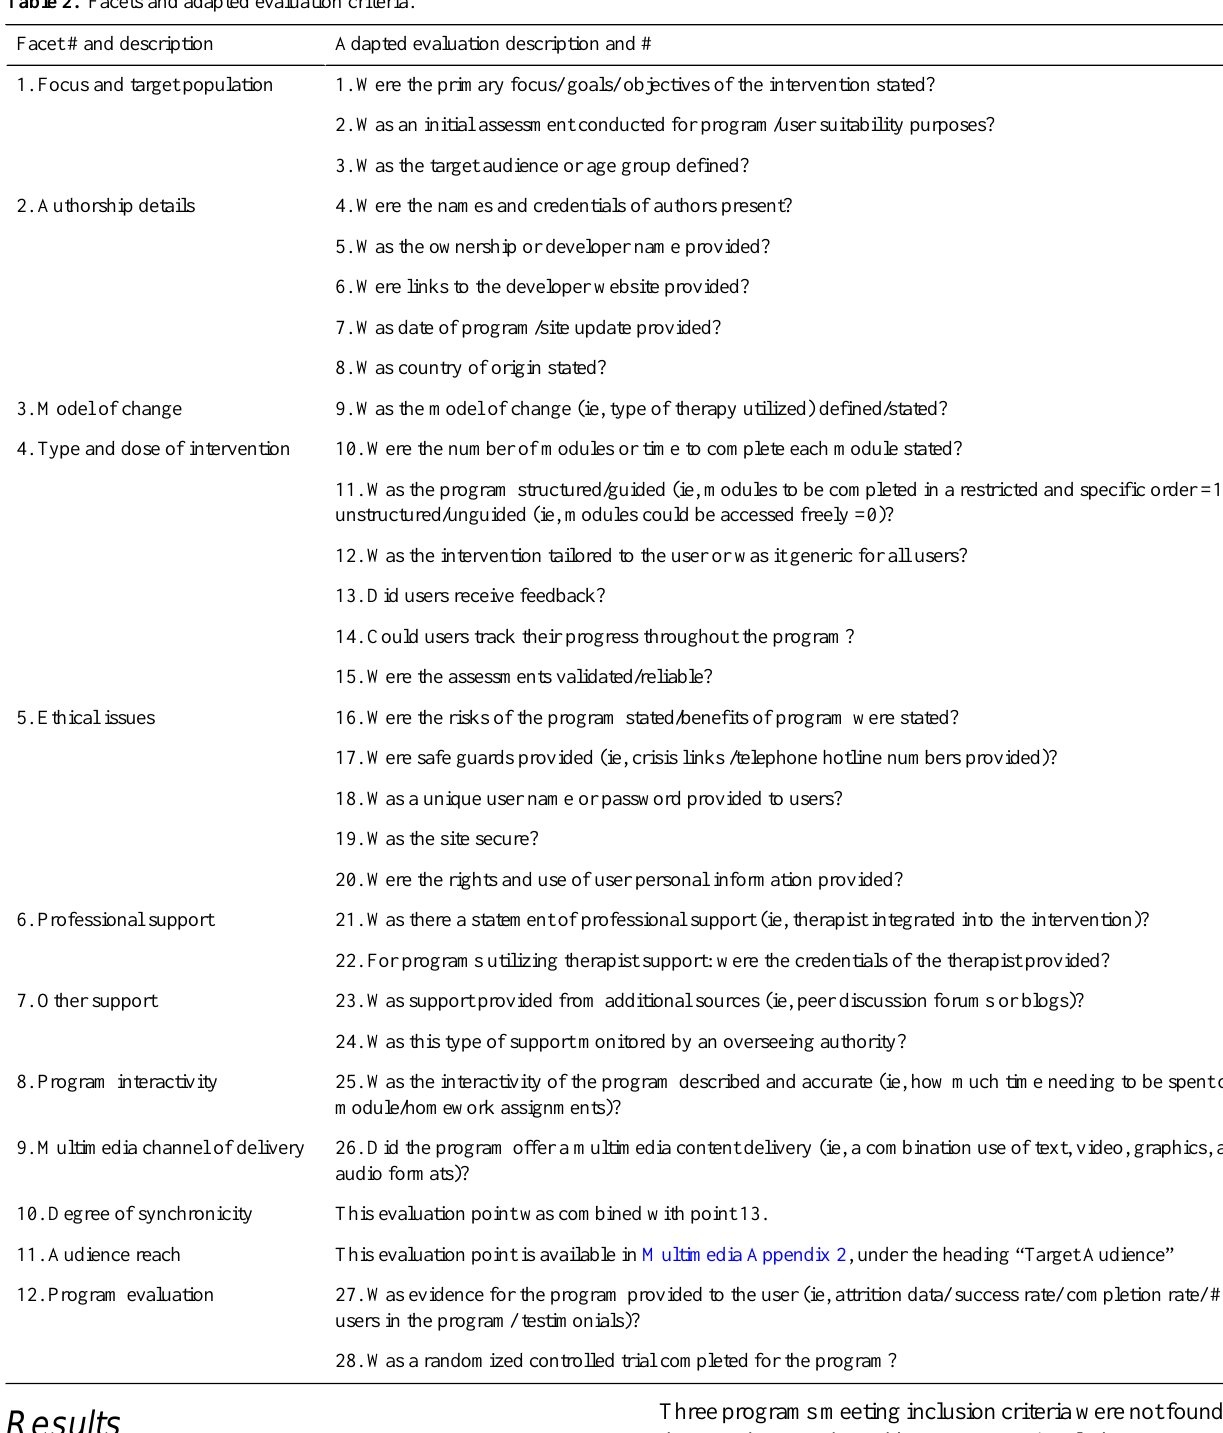
Table 2. Facets and adapted evaluation criteria.